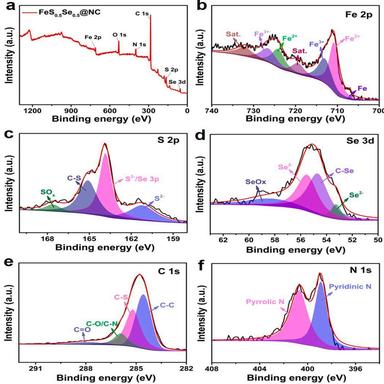
XPS spectra of FeS0.5Se0.5@NC: (a) Survey spectrum, high resolution XPS spectra of (b) Fe 2p, (c) S 2p, (d) Se 3d, (e) C 1s, and (f) N 1s.